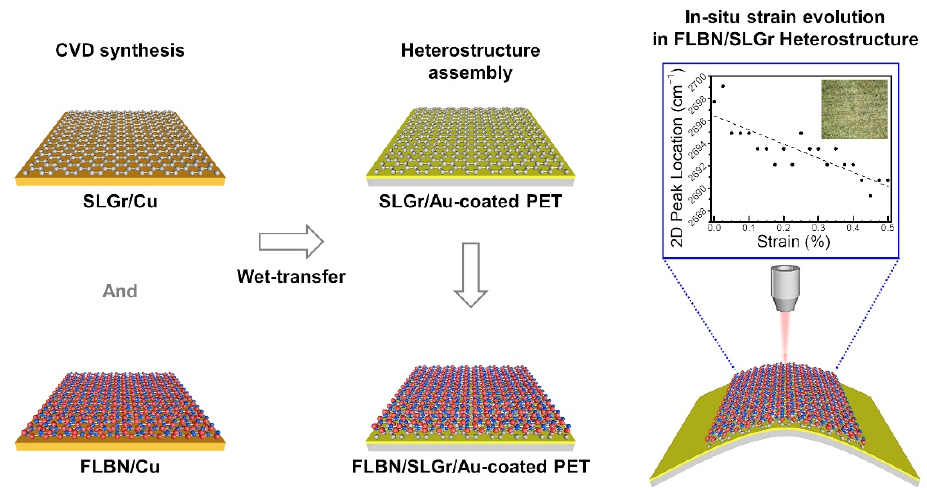
Figure 1. A schematic diagram illustrates the production process of FLBN/SLGr heterostructures on PET substrates. The left column shows the CVD growth of SLGr or FLBN on Cu substrates. The middle column shows the prepared Au-coated PET substrate followed by the FLBN/SLGr heterostructure assembly. The right column shows the schematic of the strained configuration of the FLBN/SLGr heterostructure on Au-coated PET substrates with in situ Raman spectroscopy (inset in the right column depicts a representative strain evolution measurement plot and optical image of the probed